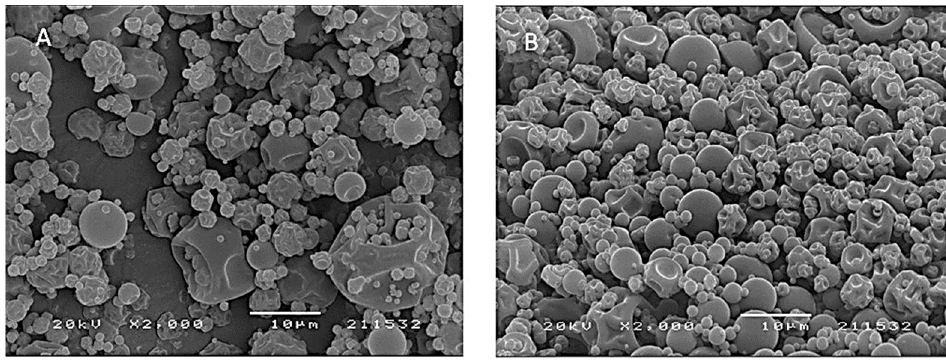
Figure 7. SEM images of sorghum microparticles obtained with spray-drying by maltodextrin ( A ) and Arabic gum ( B ), (magnification 2000×).